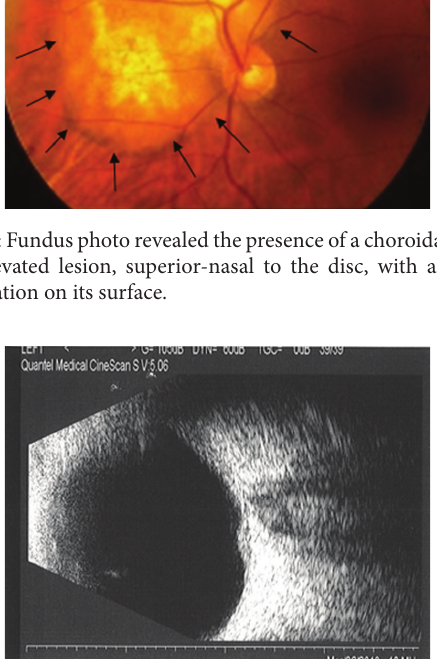
Figure 5: B-scan ultrasound showed a complete regression of the choroidal lesion after 4 cycles of chemotherapy and intravenous bevacizumab.